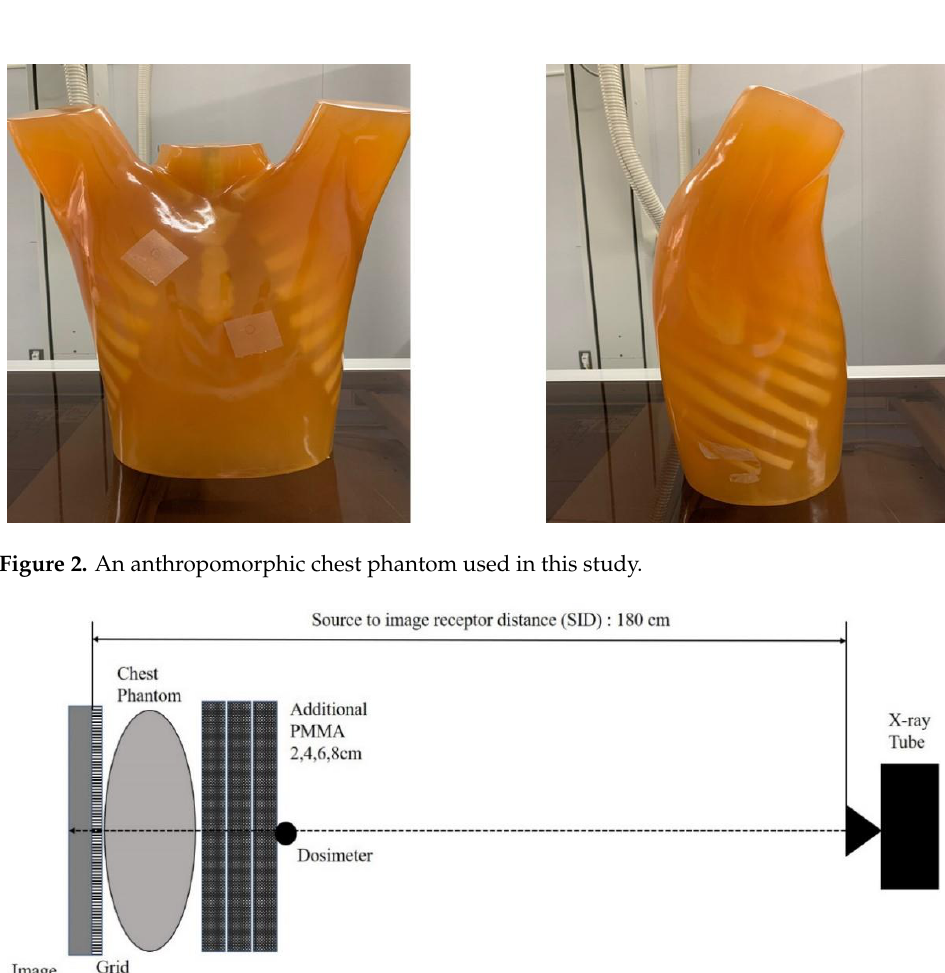
Figure 3. Scheme of experimental geometry in this study.